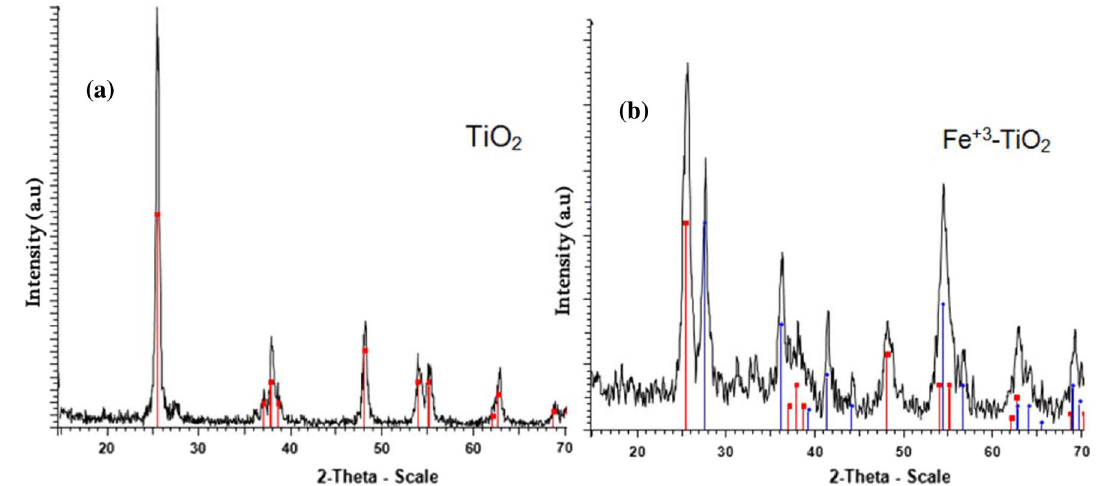
3+ –TiO 2 ( a ) and Fe 2 ( b )